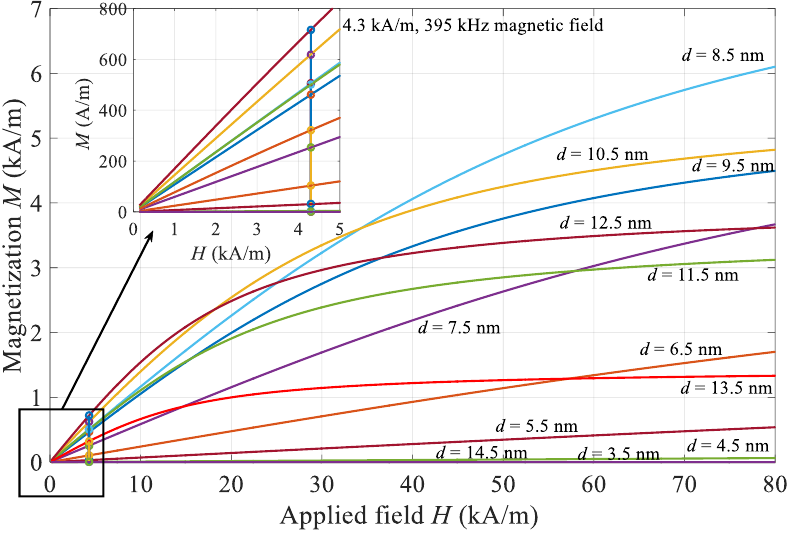
Figure 7. Magnetization of various size particles for a magnetic field of 4.3 kA/m and 395 kHz.